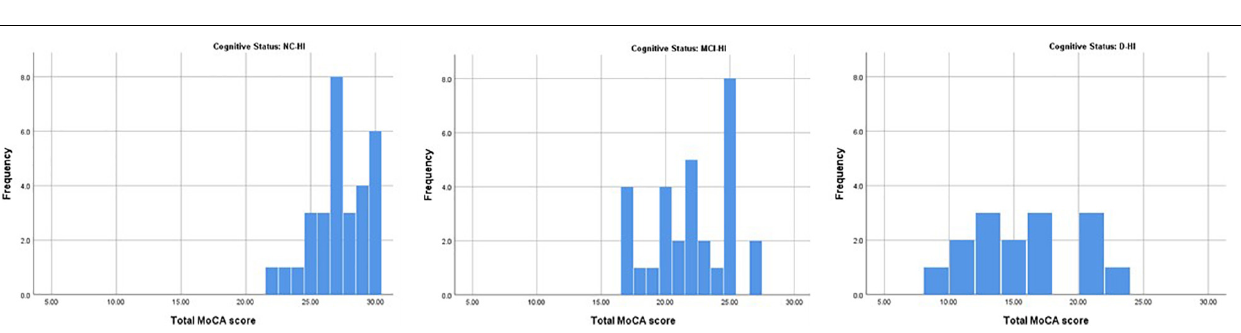
FIGURE 1 | The Boxplots demonstrated the mean MoCA-HA score of the NC-HI, MCI-HI, and the D-HI cohorts.